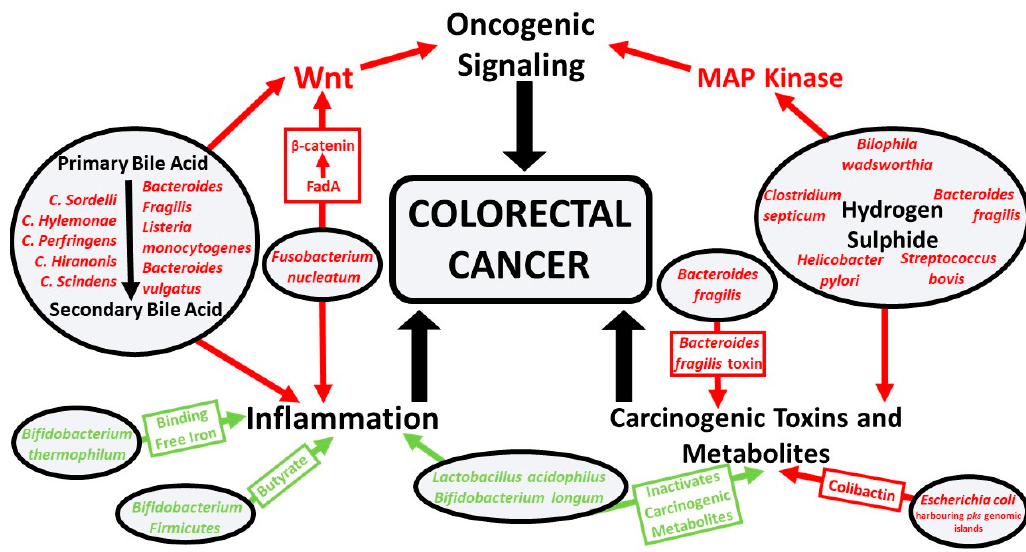
Figure 1. Protective and pathogenic bacterial species and microbial pathways involved in colorectal cancer. The three major microbially induced pathways that contribute to colorectal cancer are inflammation, oncogenic signaling, and carcinogenic toxin and metabolite production. Symbionts (green) inhibit these pathways and pathobionts (red) promote these pathways.